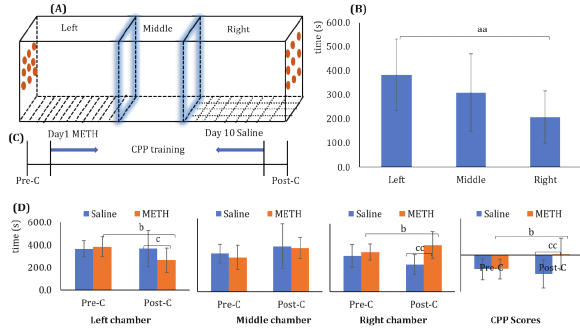
Figure 1: METH-induced CPP in rats. (A) CPP training and testing equipment consisted of two large side chambers with different floor textures (bar floor in the left vs grid floor in the right, respectively) and a smaller middle chamber with a smooth PVC floor; (B) Historical laboratory data of rat’s natural preference, n = 630; (C) Protocol of CPP training and test; (D) Comparison of METH